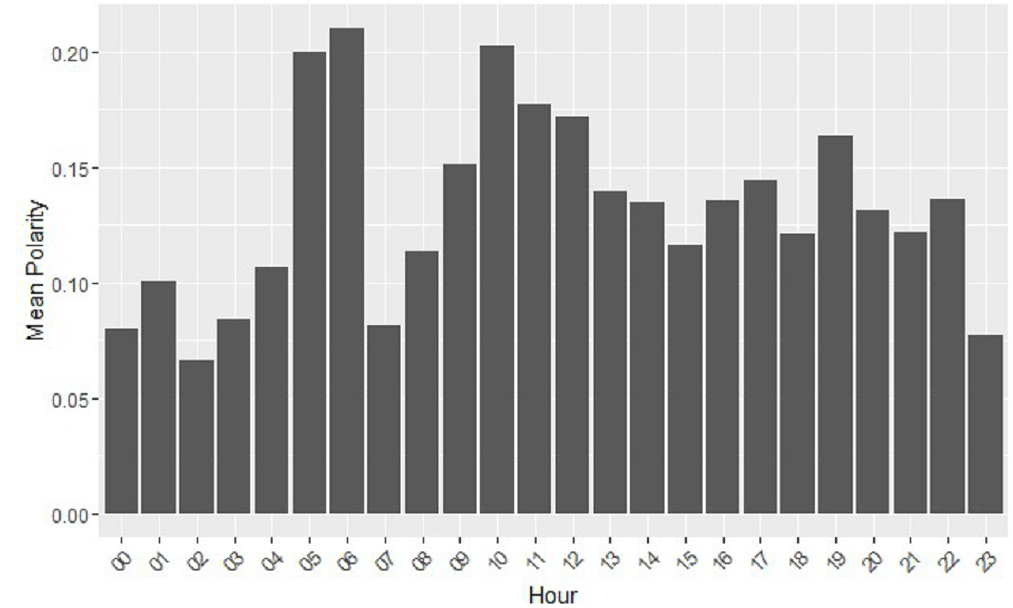
Figure 4. Mean polarity vs. hour.